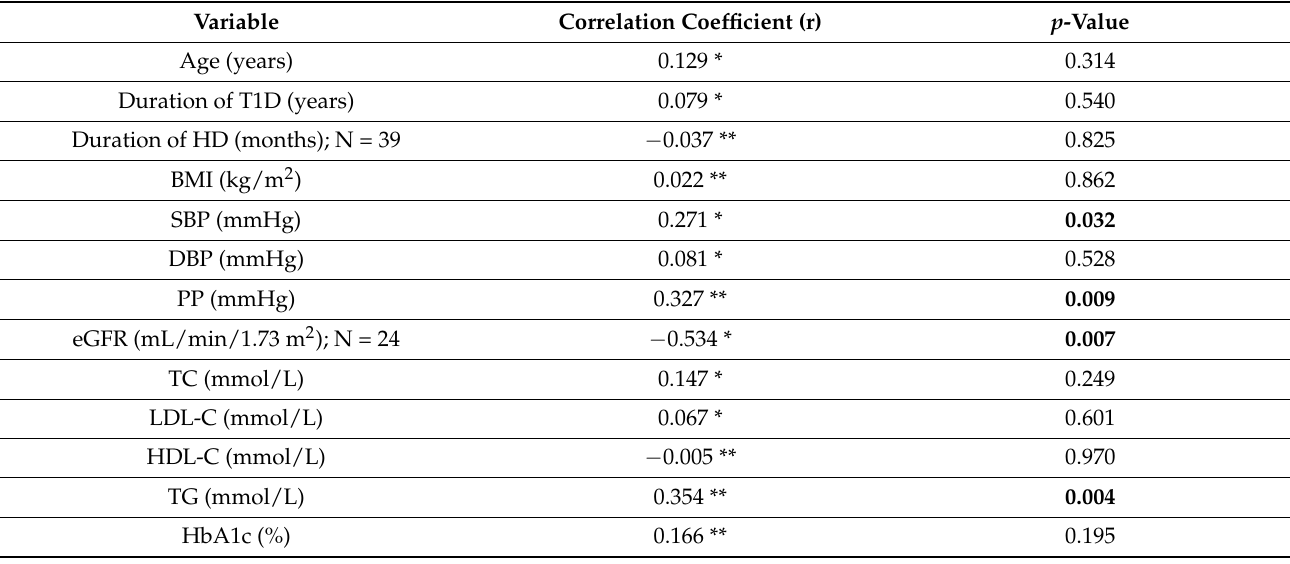
Table 2. Correlations between uric acid concentration and selected clinical and laboratory parameters (N =